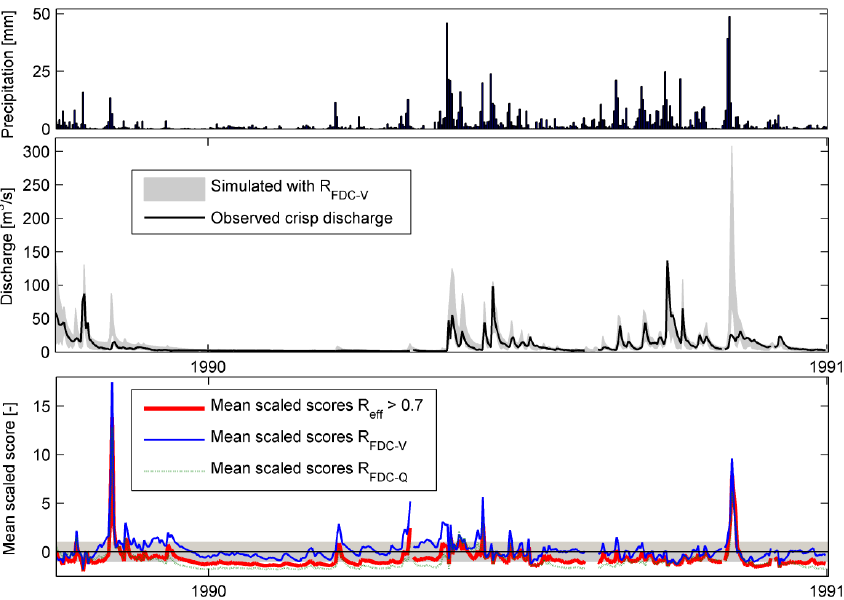
Fig. 14. Daily precipitation in 1989–1990 (top) and predicted and observed crisp daily discharge for behavioural parameter-value sets from using R FDC − V for calibration of WASMOD in the Paso La Ceiba catchment in 1980–1988 (middle). The mean scaled scores for all performance measures are plotted in the bottom plot where the grey area represents a scaled score from − 1 to 1, i.e. a simulated discharge with a score inside this range is inside the discharge uncertainty limits.